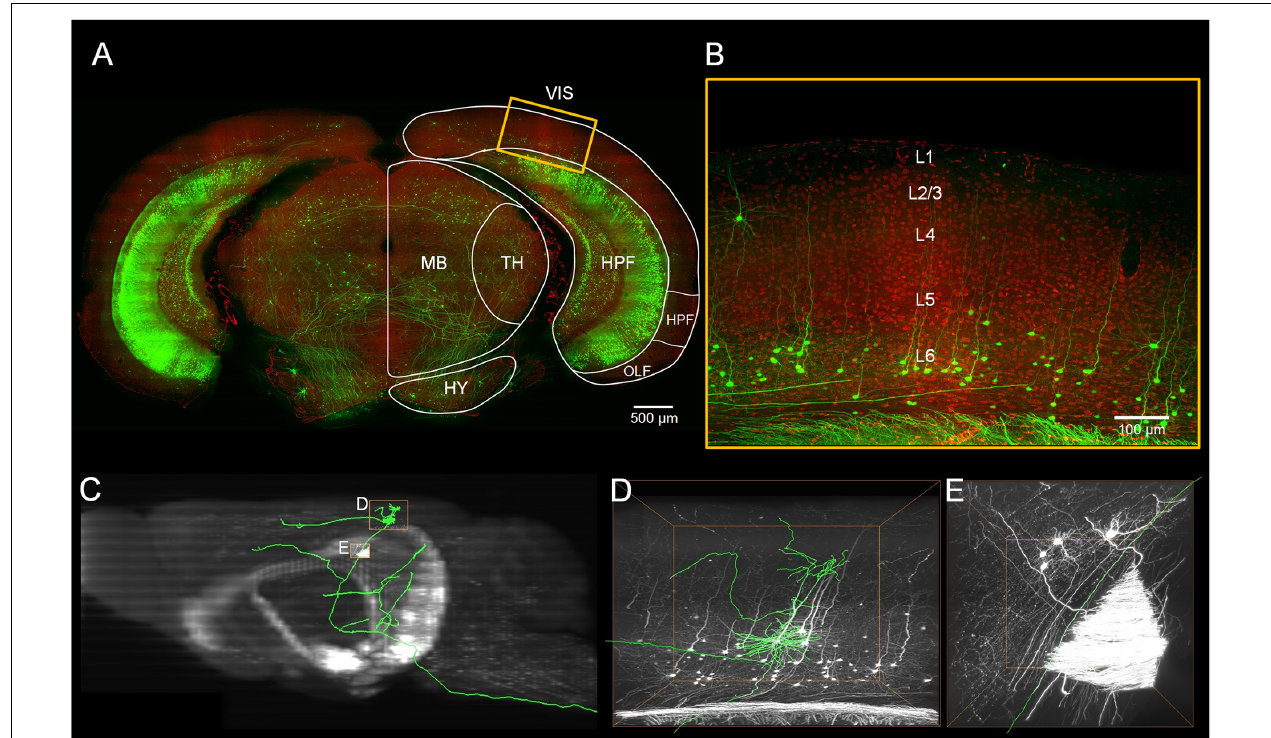
FIGURE 1 | Localization of the visual cortex and annotating the individual neurons inside. (A) Merged image with green channel (thickness of projection: 500 µ m) and red channel (thickness of projection: 5 µ m). The white outline indicates brain regions: the visual areas (VIS), the hippocampal formation (HPF), the thalamus (TH), the midbrain (MB) and the hypothalamus (HY). Scale bar: 500 µ m. (B) Enlarged view of the region marked with the yellow rectangle in (A) . The YFP-labeled individual neurons and the propidium iodide (PI)-stained cytoarchitecture are shown. Scale bar: 100 µ m. (C) The maximal projection of the sagittal plane of the green channel dataset. (D,E) Three-dimensional enlarged view of the region marked with the yellow rectangle in (C) .